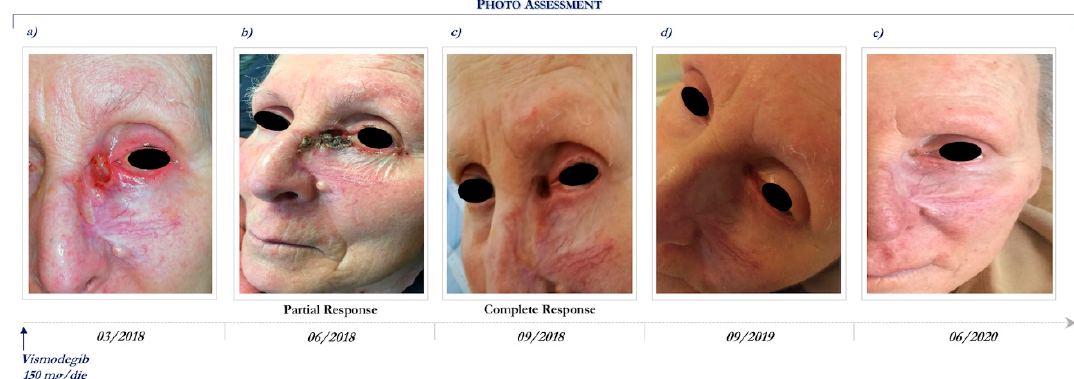
Figure 3. Clinical case report 2 of locally advanced BCC . Case report 2. Photo assessment: before vismodegib treatment ( a ); after 28 days of vismodegib ( b ); partial clinical response at 6 months ( c ); onset of complete clinical response ( d ); ongoing clinical benefit ( e ).